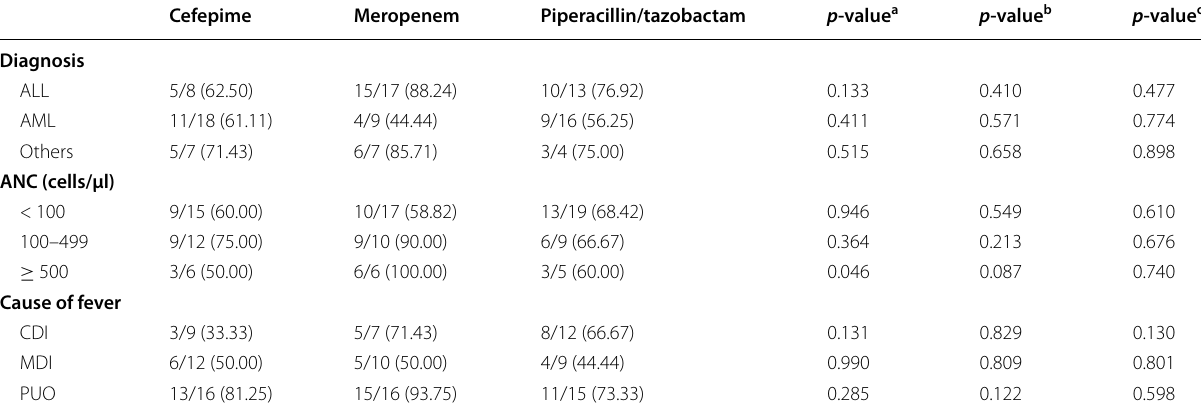
Table 4 Clinical response according to underlying disease, baseline neutrophil counts, and cause of fever (day